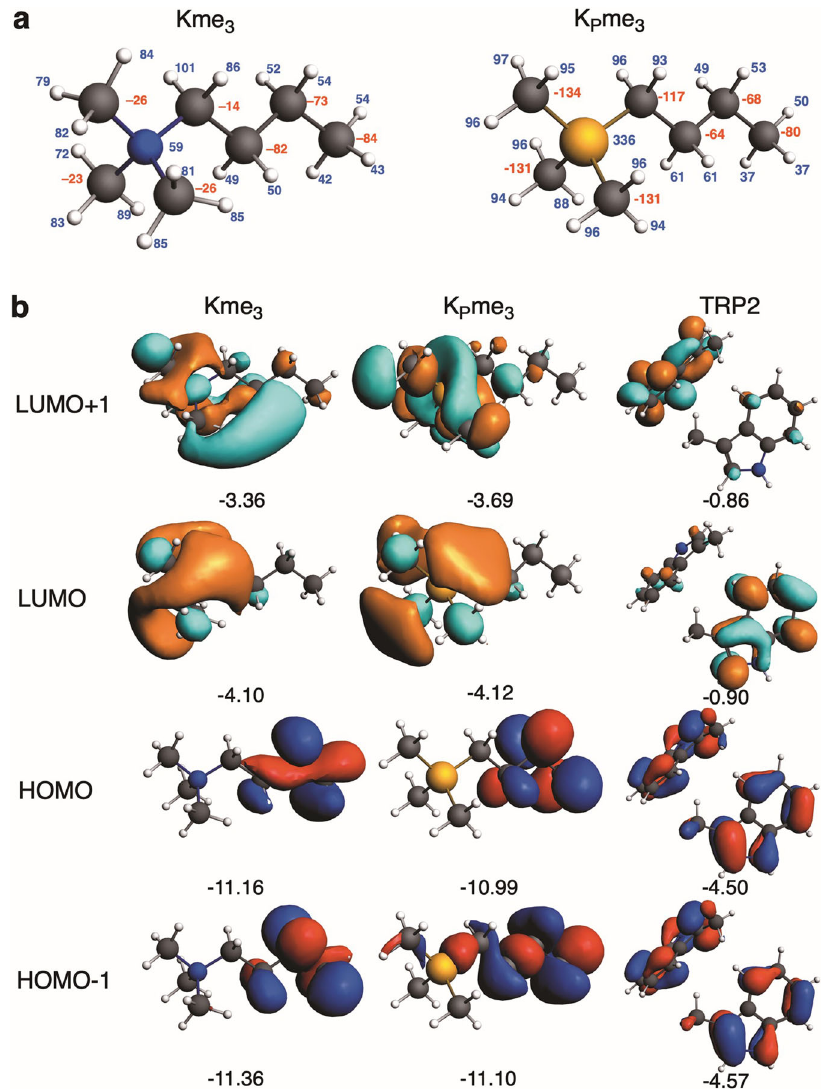
Fig. 4 Analysis of Kme 3 and K P me 3 interactions with TRP2, a model for the KDM5A PHD3 reader. The TRP2 model employs the two tryptophan residues found in KDM5A PHD3 (W1625, W1635). a Calculated VDD atomic charges (in mili-a.u.) for H3K4me 3 and H3K P 4me 3 (red: negative, blue: positive). b Frontier orbitals (with orbital energies in eV) for Kme 3 , K P me 3 , and TRP2, (isosurface drawn at 0.03), computed at the BLYP-D3BJ/TZ2P level using an X-ray structure for TRP2